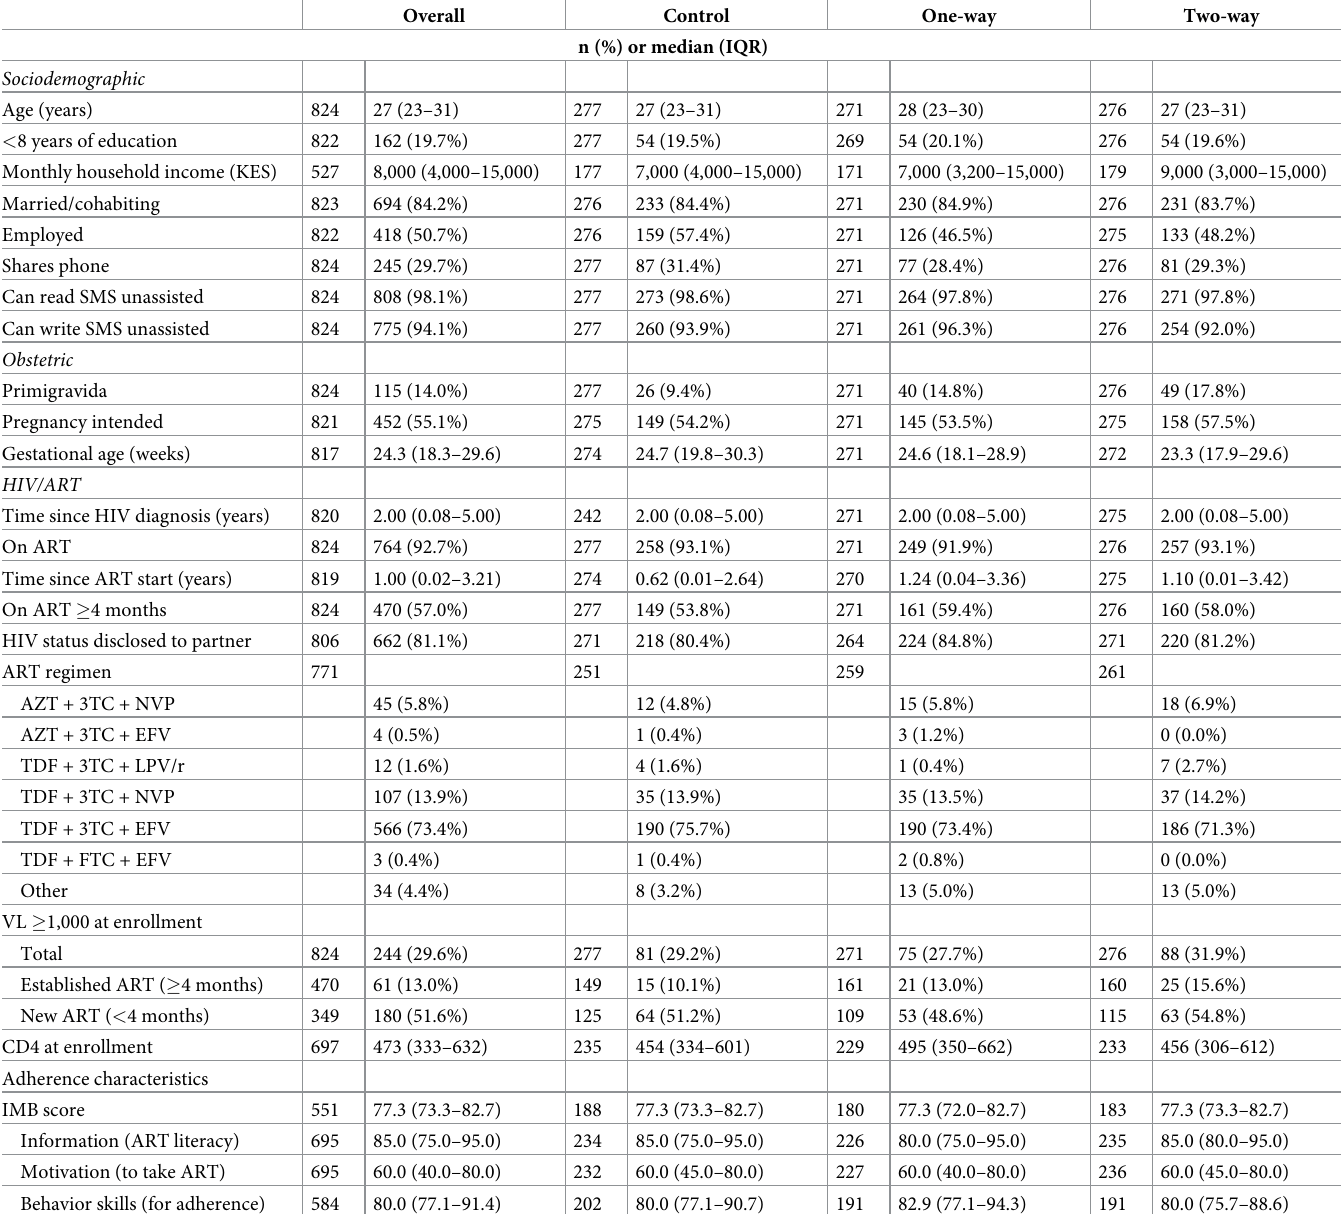
Table 1. Participant baseline